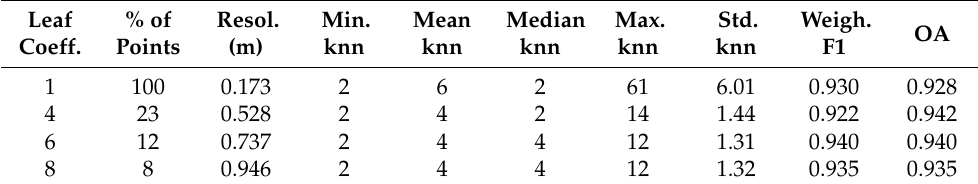
Table 5. Density Analysis on Bordeaux dataset.